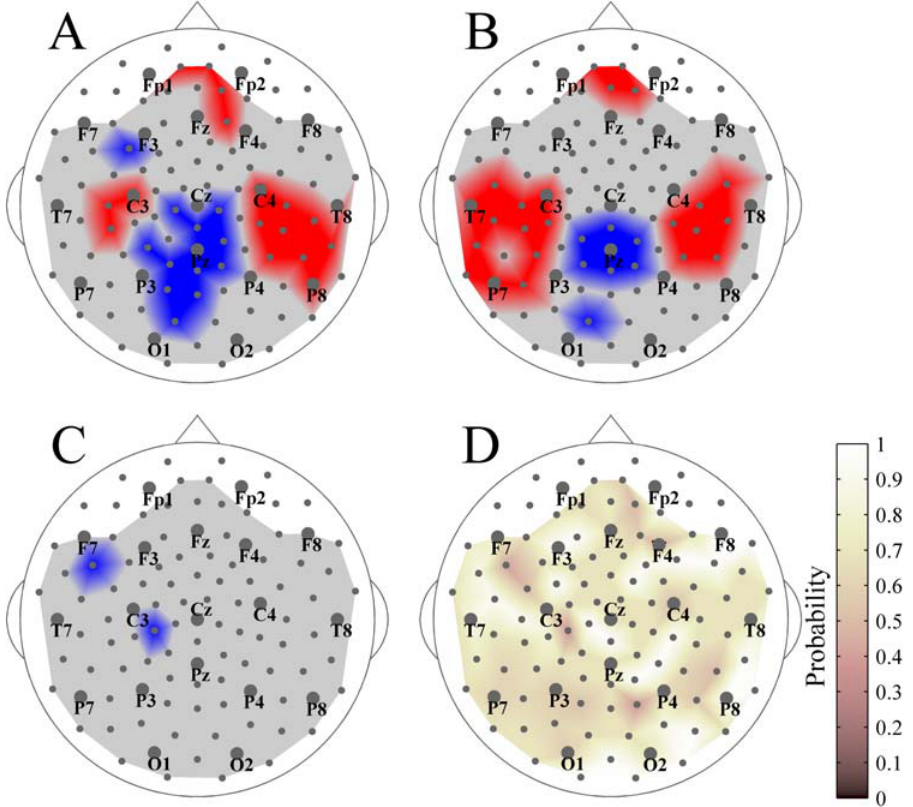
Figure 4. Temporal stability of the S-estimator topography in SZ. Group-averaged difference maps (Patients vs. Controls) for the broad-band EEG from ten patients who participated in the first (A) and second (B) EEG sessions. C: Difference map between the first EEG vs. second EEG of patients. The regions where the S-estimator in the patients’ first EEG was significantly higher or lower than that in the second EEG are in red or in blue, respectively. There are no significant differences in the gray regions. D: Map of the likelihood that the synchronization estimations from the first and second EEG can be considered stationary according to Kolmogorov-Smirnov test. The color is inversely related to the probability: the lighter, the more probable.